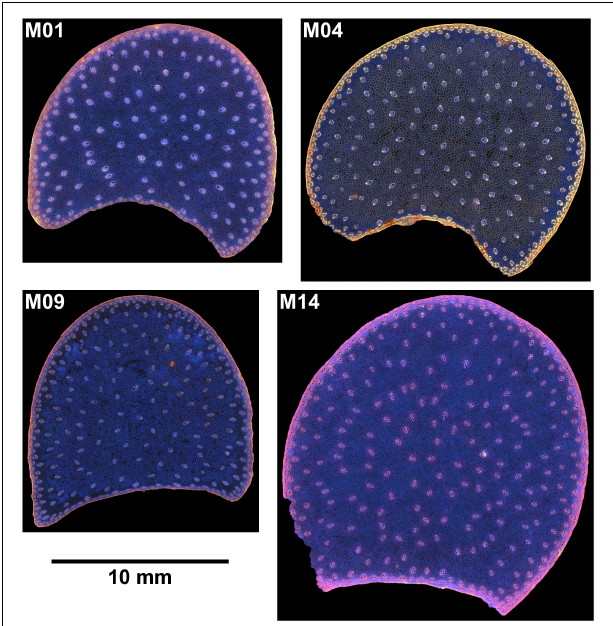
FIGURE 5 | Composite macrofluorescence images: Example of large images for four inbred lines. The composite macrofluorescence images shows the homogeneity of fluorescence around the rind, vascular bundles, and within parenchyma.